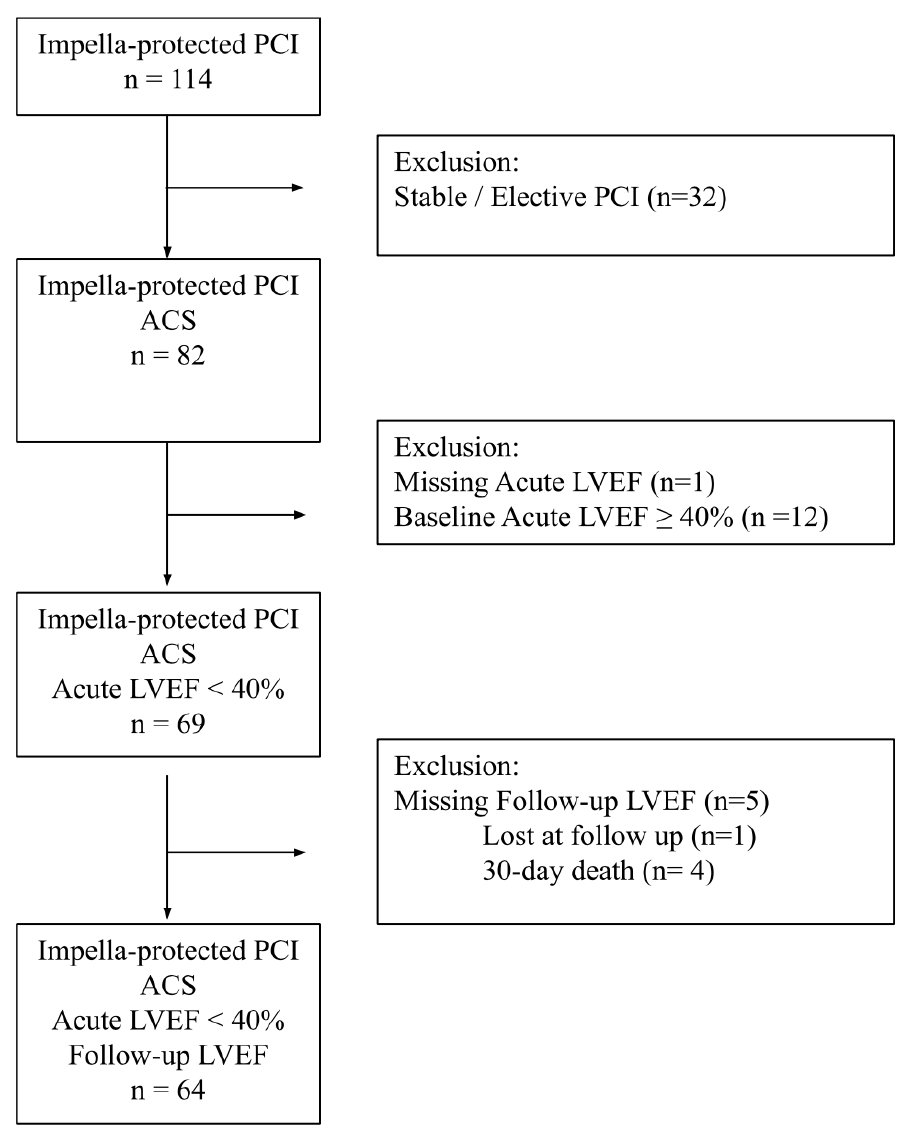
Figure 1. Flow chart of the study protocol.